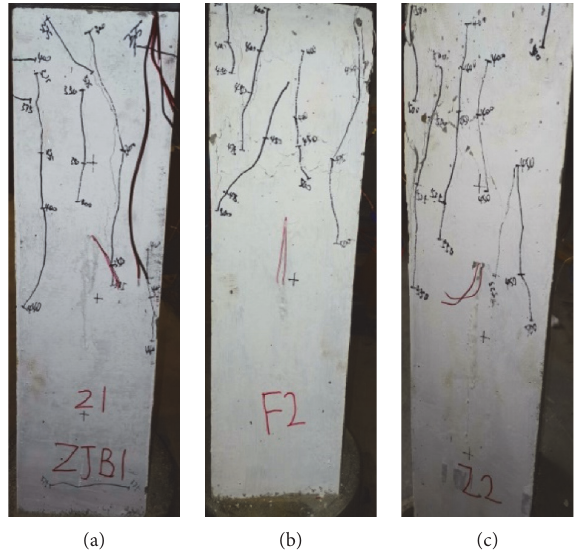
Figure 8: Failure patterns of specimens ZJB: (a) ZJB1, (b) ZJB2, and (c)